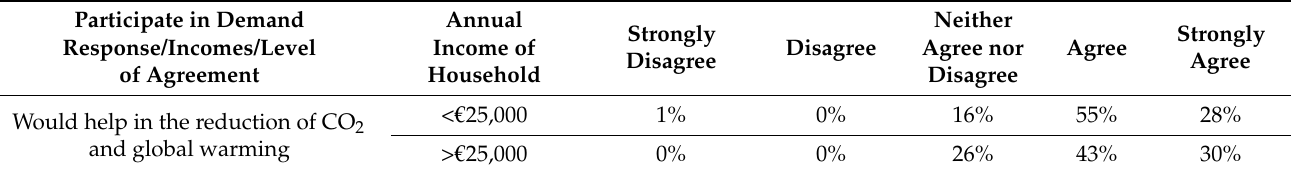
Table 5. Consumers interest in the climate (by level of income).